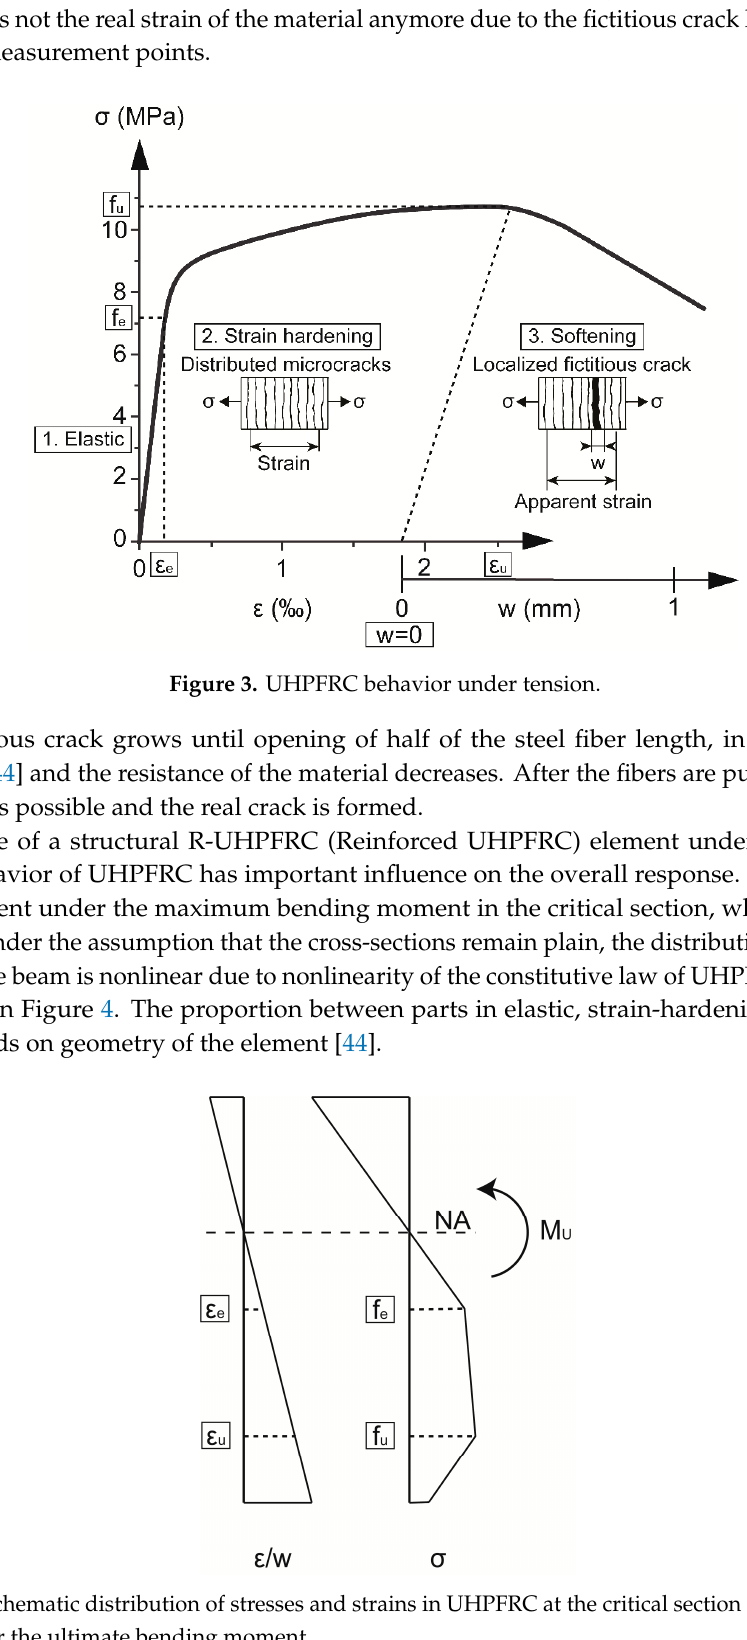
Figure 4. Schematic distribution of stresses and strains in UHPFRC at the critical section of R-UHPFRC beam under the ultimate bending